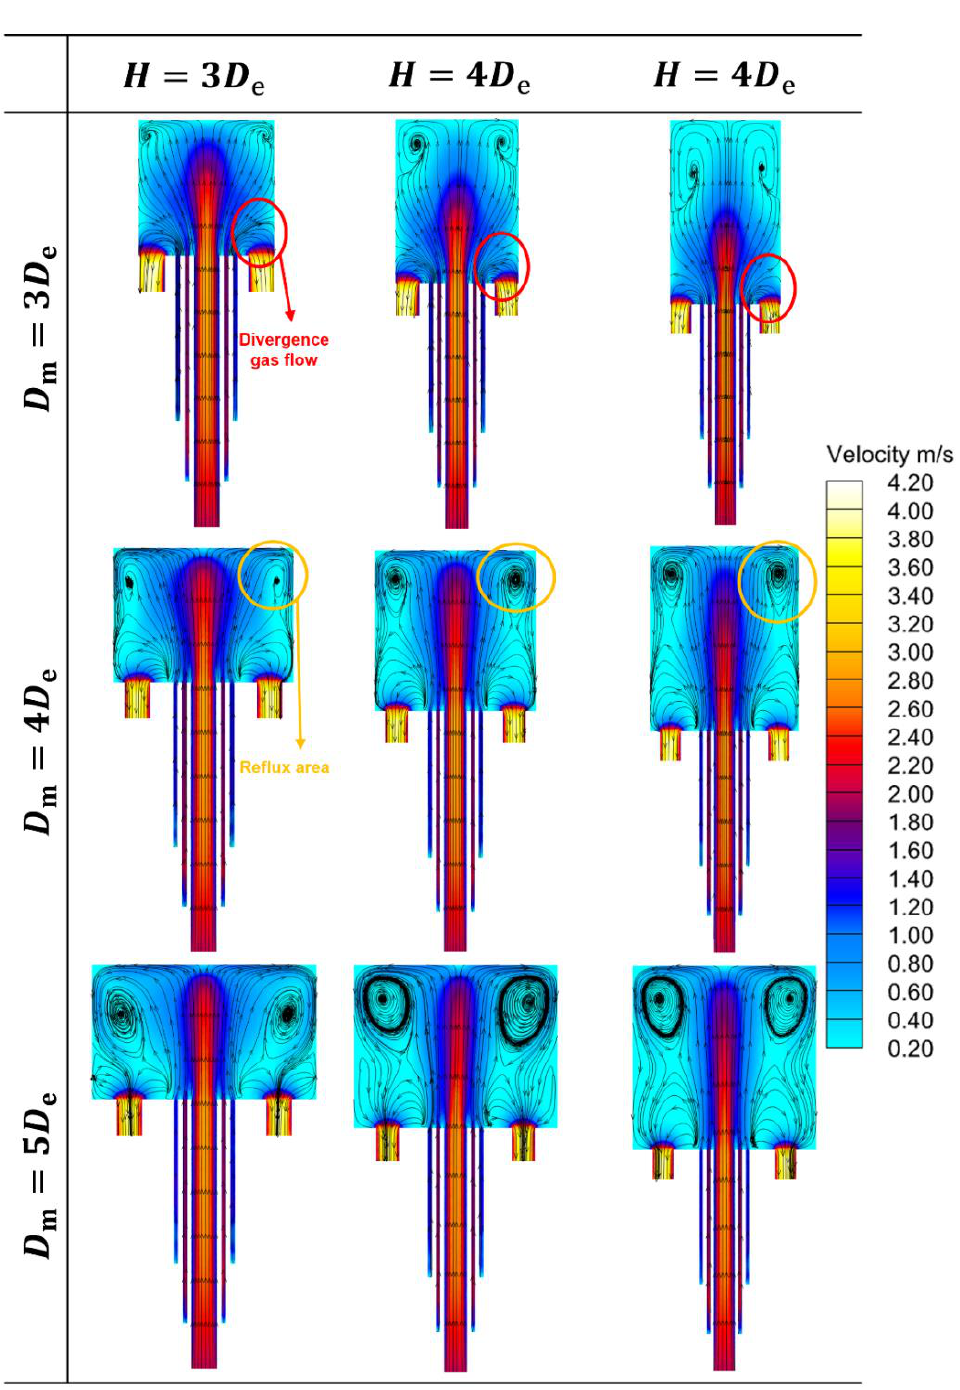
Figure 6. Velocity contours and streamlines of different chamber sizes.